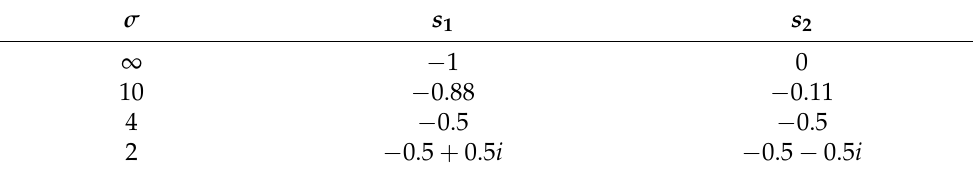
Table 2. The closed loop poles for a second order system, where the ratio of the time constants of the outer and inner loop is σ . For σ → ∞ , we have a perfect timescale separation with the closed loop poles equal to the poles of the inner loop ( s 1 = − 1) and the outer loop ( s 2 = 0). For σ = 10 (the outer loop is ten times slower than the inner loop), we still obtain a reasonably good timescale separation. For σ = 4 the two poles coincide (corresponding to critical damping) and for values of σ < 4, e.g., σ = 2, the poles become complex conjugated, resulting in a underdamped system. For the last case, the assumption of a timescale separation is clearly violated, resulting in the introduction of oscillatory behavior.